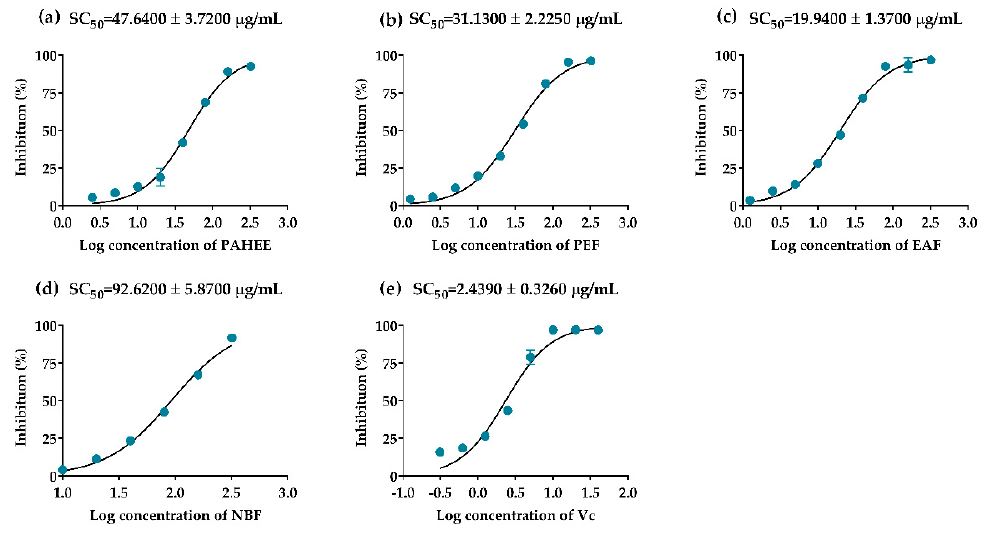
Figure 5. The scavenging effects of PAHEE and its fractions on DPPH-free radical. ( a ) Log concentration–scavenging rate fitting curve of PAHEE. ( b ) Log concentration–scavenging rate fitting curve of PEF. ( c ) Log concentration–scavenging rate fitting curve of EAF. ( d ) Log concentration–scavenging rate fitting curve of NBF. ( e ) Log concentration–scavenging rate fitting curve of ascorbic acid. Calculated the SC 50 value of different groups by Statistical Product and Service Solutions (SPSS, version: 21.0, International Business Machines Corporation, New York, USA), and all values are mean ± SD from a least three independent experiments.